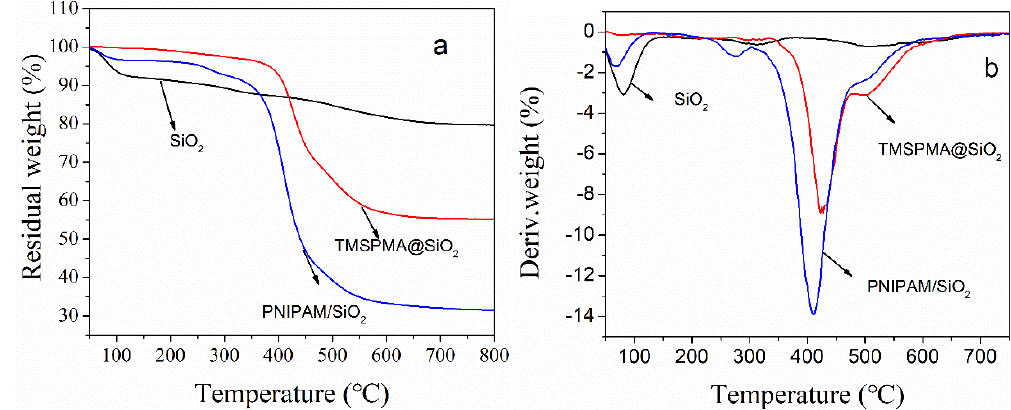
Figure 2. TGA ( a ) and DTG ( b ) thermograms of phosphate imprinted SiO 2 , TMSPMA@SiO 2 and PNIPAM/SiO 2 hybrid particles. PNIPAM/SiO 2 hybrid